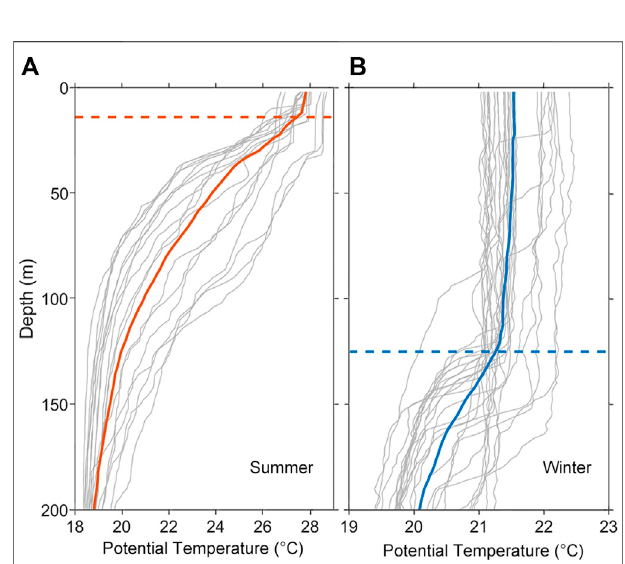
FIGURE 3 | Upper 200 m potential temperature pro fi les measured by XBTs. (A) Pro fi les measured in summer (represented by July): the light gray curves are actual pro fi les measured individually, the orange solid curve is their average, and the dashed orange line marks the mean surface mixed layer depth in summer, 14 m. (B) Pro fi les measured in winter (represented by December): the light gray curves are actual pro fi les measured individually, the blue solid curve is their average, and the dashed blue line marks the mean surface mixed layer depth in winter, 125 m.